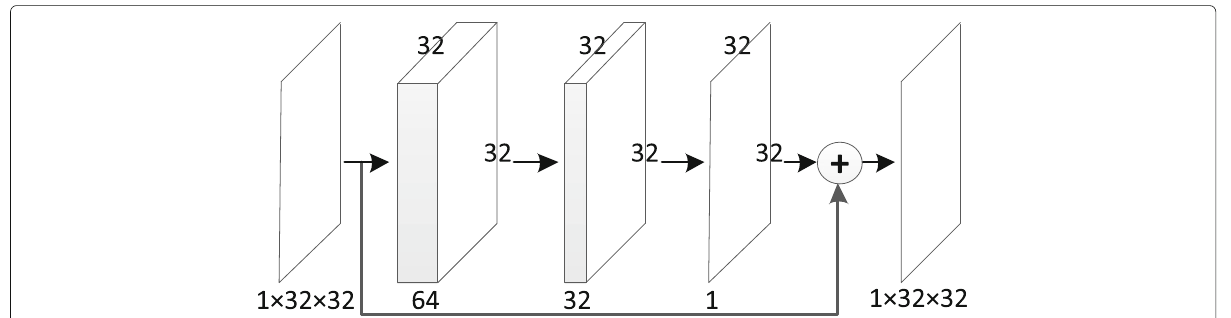
Fig. 3 The framework of residual reconstruction module